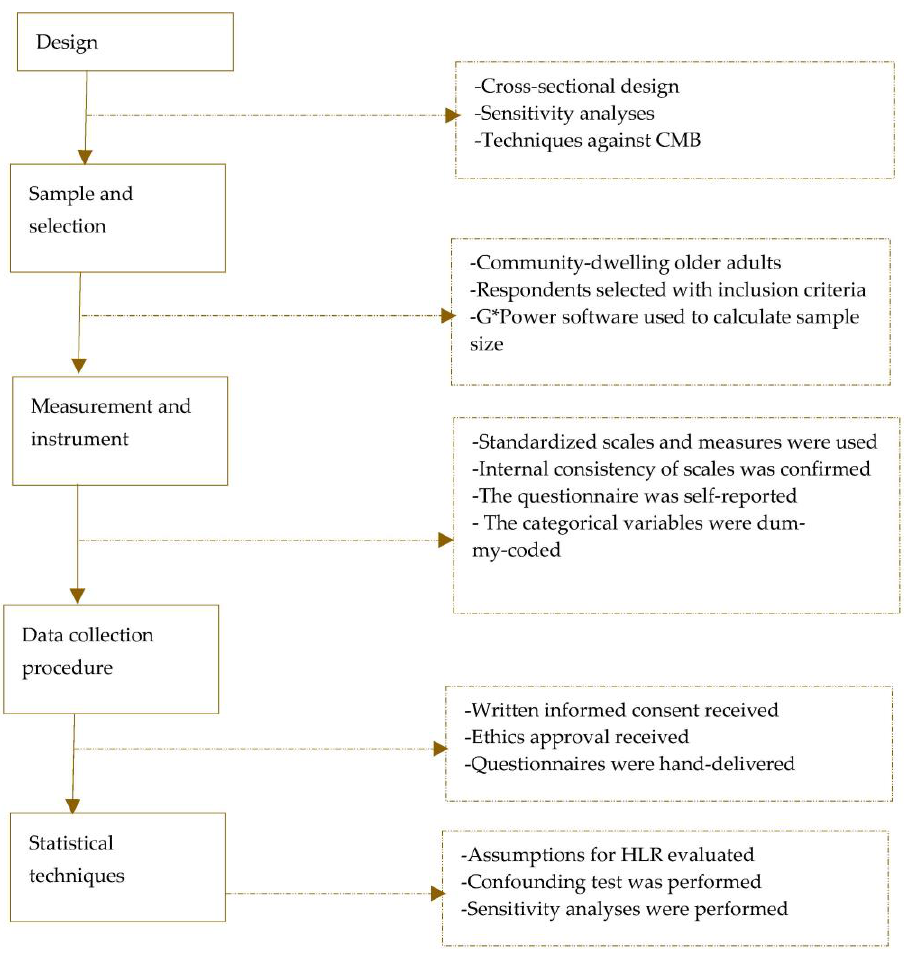
Figure 1. Elements of the STROBE-based design. HLR—hierarchical linear regression; CMB—common method bias.